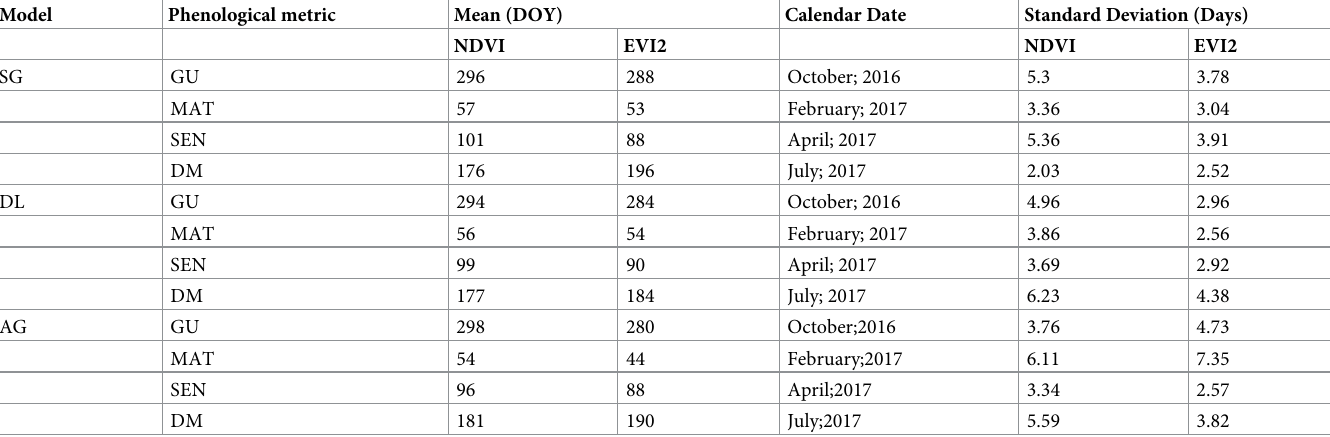
where GU = green up; MAT = maturity; SEN = senescence; DM =